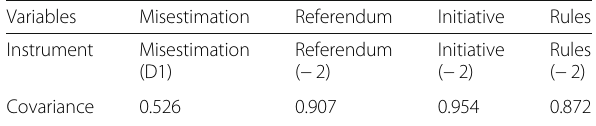
Table 7 Breusch-Pagan/Cook-Weisberg test for